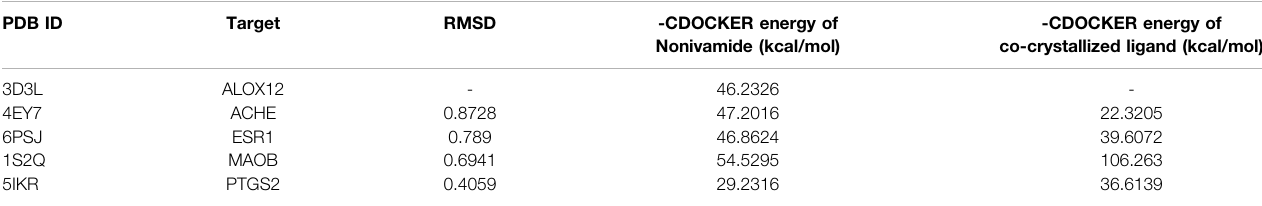
TABLE 3 | The targets for molecular docking and their PDB ID, RMSD value and -CDOCKER energy of Nonivamide and the co-crystallized